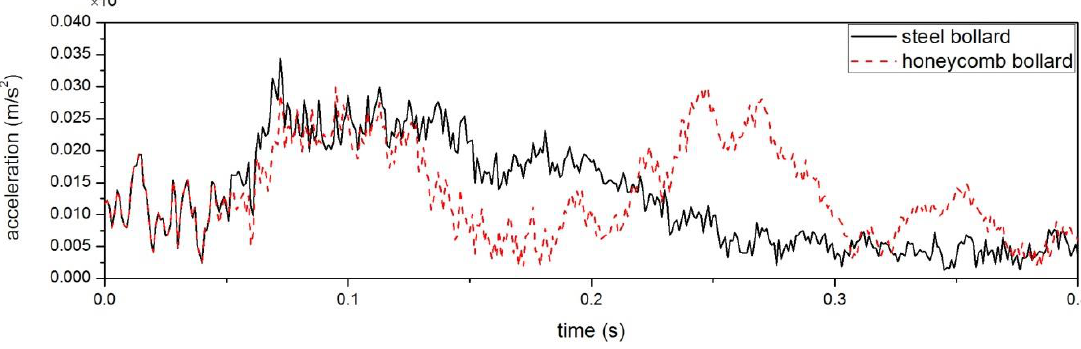
Figure 9. Simulated acceleration evolutions at the B-pillar.